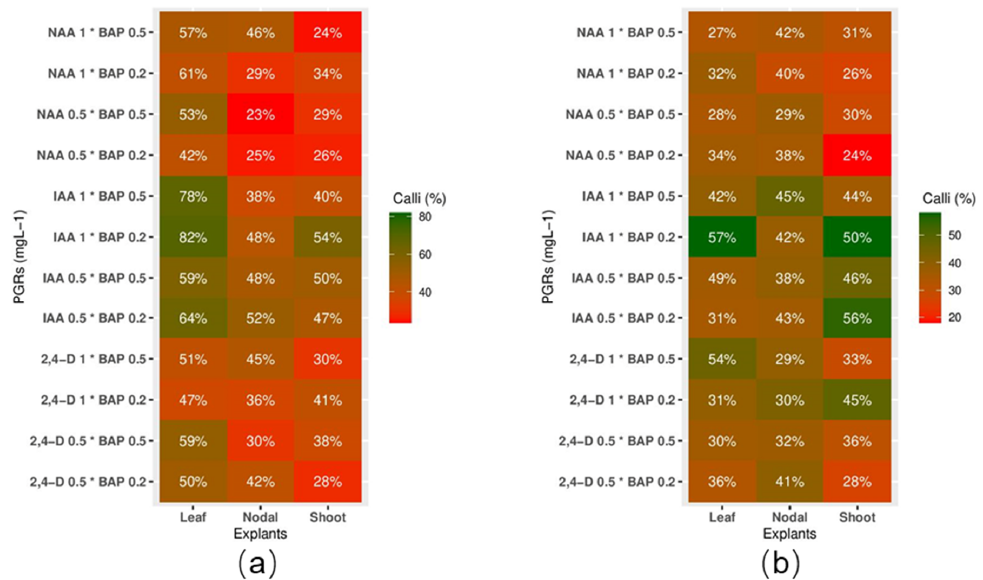
Figure 2. Callus induction frequency of Greater Celandine. ( a ) Callus induction rate using different plant growth regulators PGRs and explants on MS medium. ( b ) Callus induction rate using different PGRs and explants on B5 media. Each cell in the heatmap represents the mean value of six replicates. * represents the combination of PGRs.